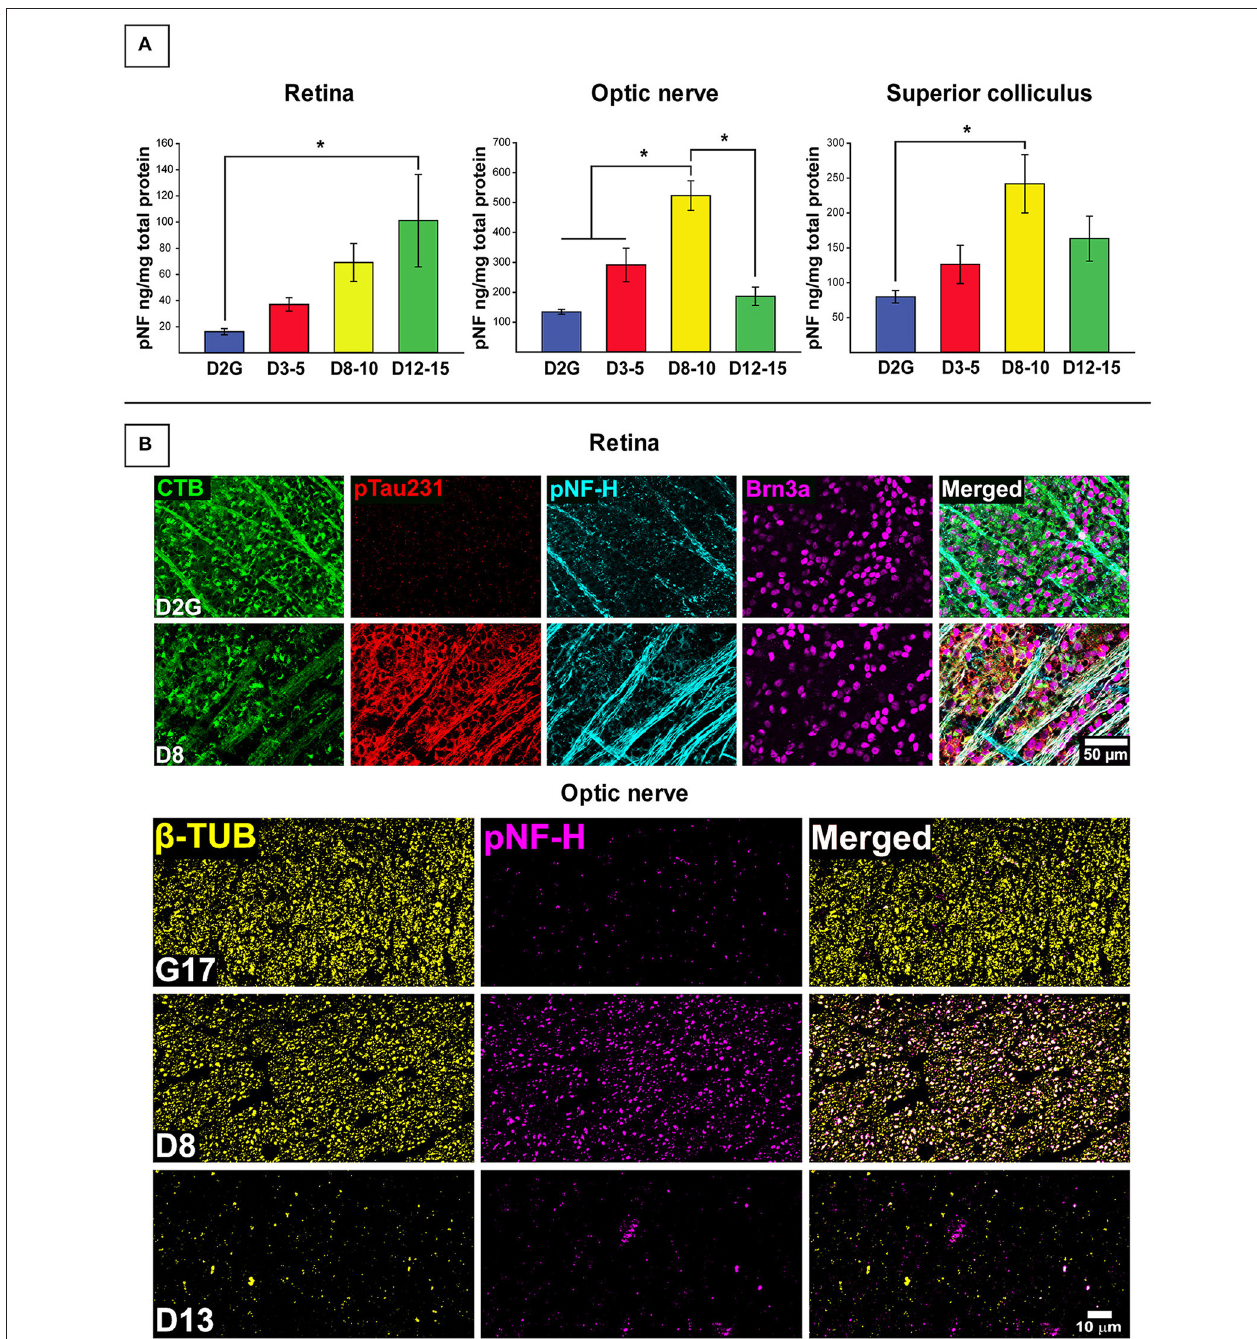
FIGURE 1 | Early elevations in pNF-H observed in distal RGC projection with effects of age and transport outcome. (A) Quantification of pNF-H by ELISA in retina, optic nerve (ON), and superior colliculus (SC). DBA/2J retinal pNF-H levels show trending increase with age peaking at 12–15 months at which point, is significantly elevated compared to the D2G controls. In the ON, pNF-H levels were highest at 8–10 months. in the DBA/2J mice but returned to levels similar to the D2G controls at 12–15 months. In the SC, pNF-H levels remained significantly elevated in the D8-10 group compared to controls. (B) (Top) Immunofluorescence of cytoskeletal markers, SMI-310 (specific for superphosphorylated, pNF-H) and the RGC marker Brn3a in the retina of an 8-mo. DBA/2J (D8) and D2G control. Micrographs show visibly increased pNF-H and somatic/axonal ptau-231 staining in the D8 retina. The D2G pNF-H labeling is typical of mature, non-pathological axons within the retina. (Bottom) Semithin (1 µ m) cross-sections taken from 8-months. DBA/2J (D8), 13-months. DBA/2J (D13), and 17-months. D2G (G17) control ON immuno-stained for β -tubulin ( β -TUB) and pNF-H. A significant increase in pNF-H is observed in the D8 ON compared to G17 control. In the D13, pNF-H in the ON is nearly absent corresponding to the prominent loss of axonal structure indicative by the reduction in β -TUB. Error bars depict SEM. Asterisk indicates significant statistical difference ( p < 0.05).